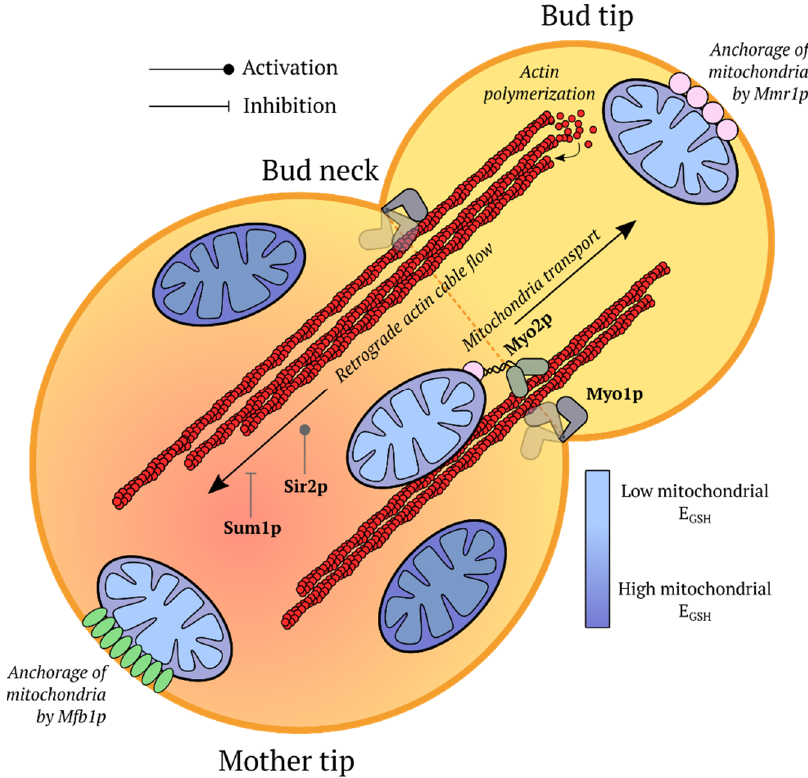
Figure 6. Inheritance of mitochondria in yeast cells. During division daughter cells on average inherit mitochondria with lower glutathione redox potential ( E GHS ) than mother cells, these mitochondria are anchored in the bud tip by Mmr1p. Mitochondria are transported to the daughter cell via actin cytoskeleton in the direction opposite to retrograde actin cable flow (RACF), which serves as a “filter” that prevents inheritance of less fit mitochondria to the bud. However, the mother cell retains a pool of high-functioning mitochondria anchored by Mfb1p in the mother tip [25–27,202,470].